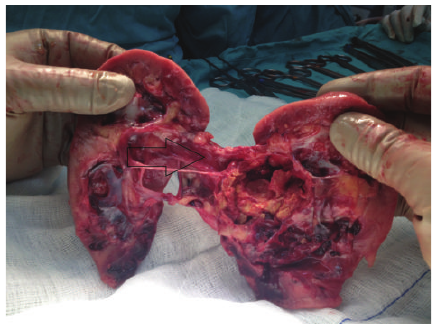
Figure 3: An intraparenchymal renal artery